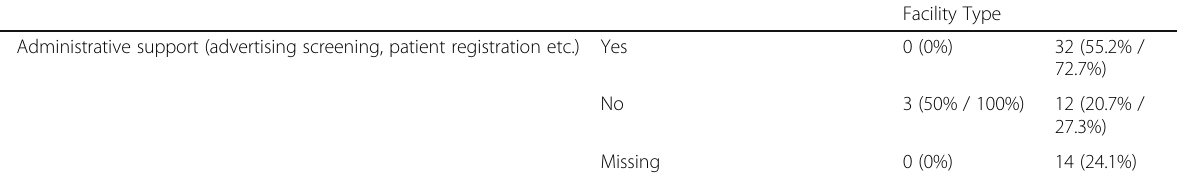
Table 4 Overview of results from survey (Continued)